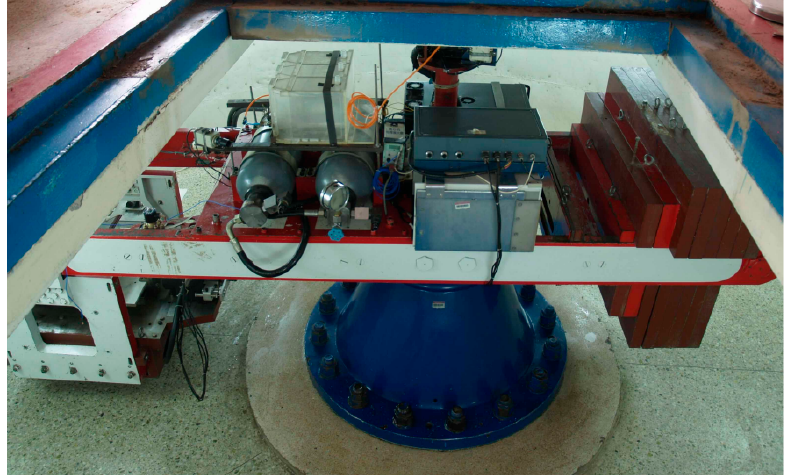
Figure 1. Centrifuge shaking table with a maximum centrifugal acceleration of 50 g at